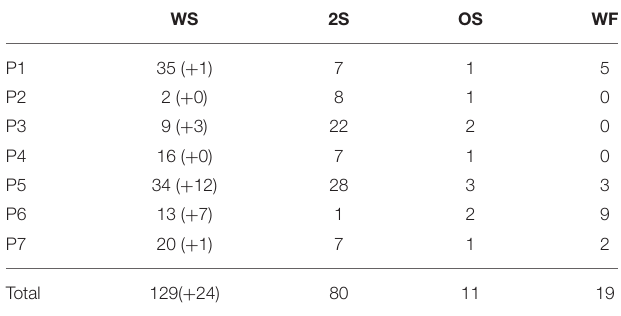
TABLE 1 | Duration, in seconds, of each performance of the Bach Courante from BWV 1002, mm. 1-32.